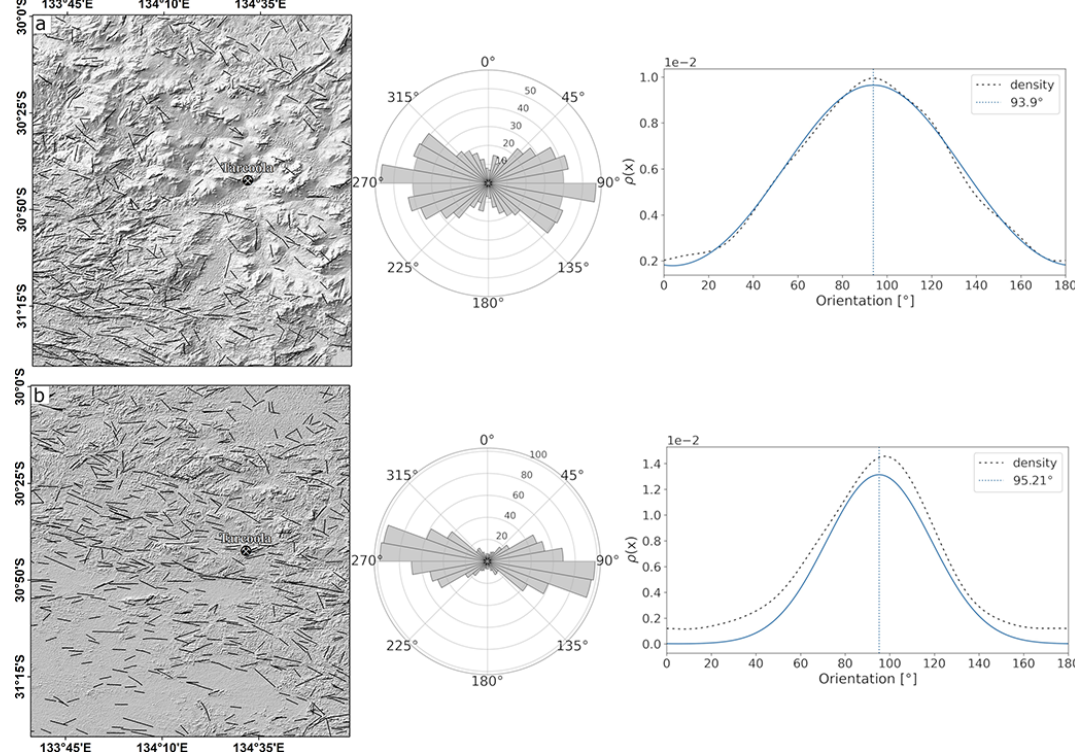
Figure 9. Lineaments detected by PCI Geomatica’s LINE module in (a) the laser altimeter data and in (b) the radiometric data (total dose rate). The base map is the mean gradient component of the respective dataset used for visualisation purposes only. To the right the rose diagram and the models fitted to the probability density function are shown for each dataset (bin size of 10 ◦